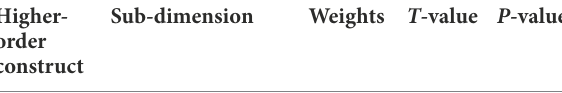
TABLE 6 Results of higher-order construct.